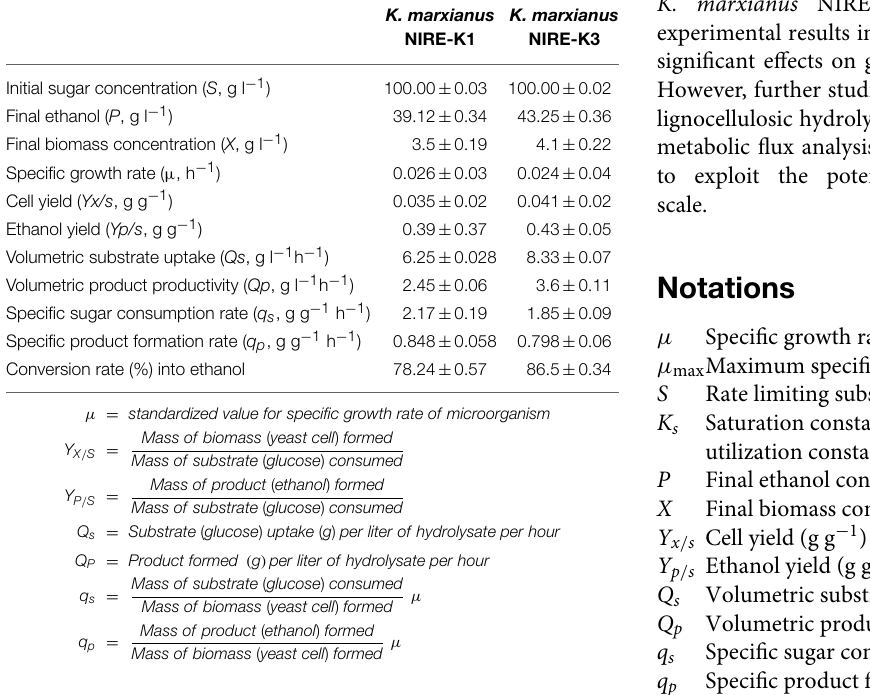
K. marxianus K. marxianus NIRE-K1